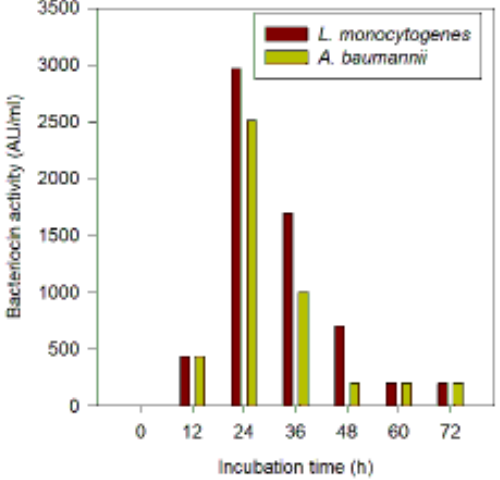
Fig. 4. Production of bacteriocin by Pediococcus pentosaceus at various incubation time